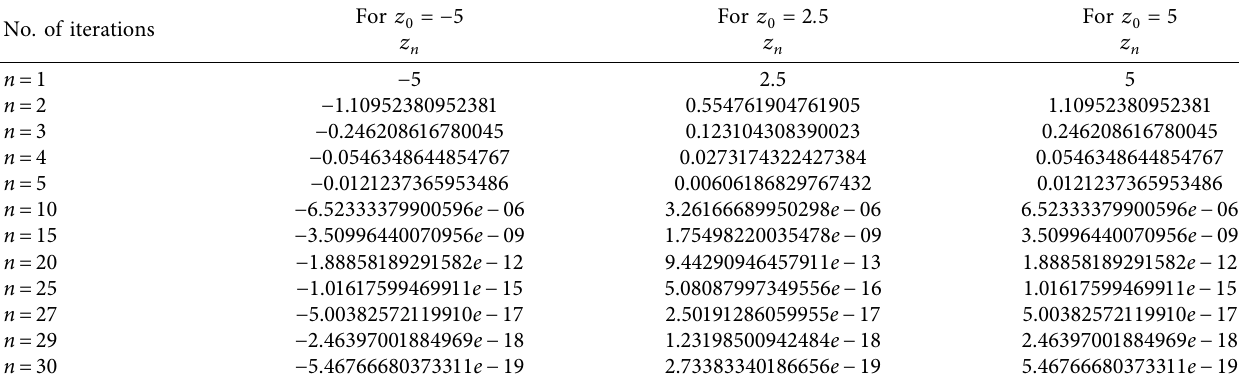
z � − 5, z � 2 . 5, and z � 0 0 0